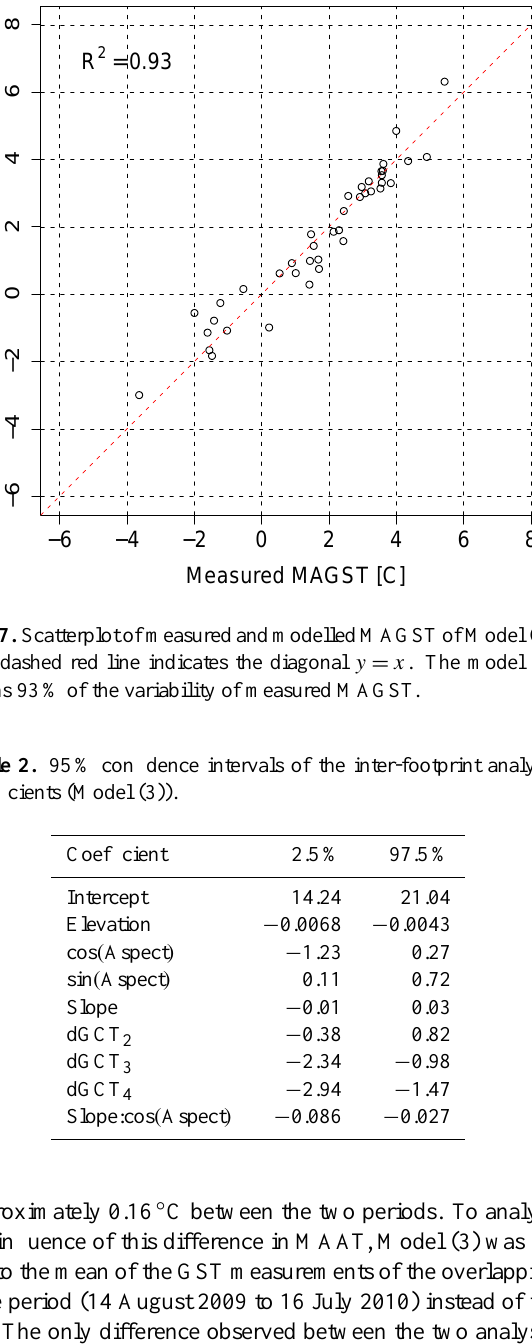
Table 3. 95% confidence intervals of the intra-footprint analysis